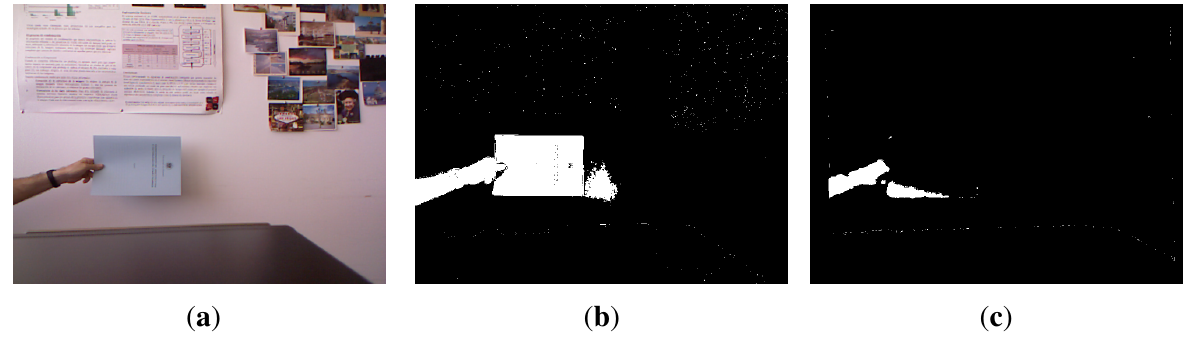
Figure 1. Example of complicated scenario for RGB-D methods: presence of shadows and flat foreground objects. Foreground objects are correctly detected by color-based algorithms, while they are misdetected by depth-based ones, since the objects are too close to the wall to be discernible. ( a ) Original frame; ( b ) RGB Detection; ( c ) Depth